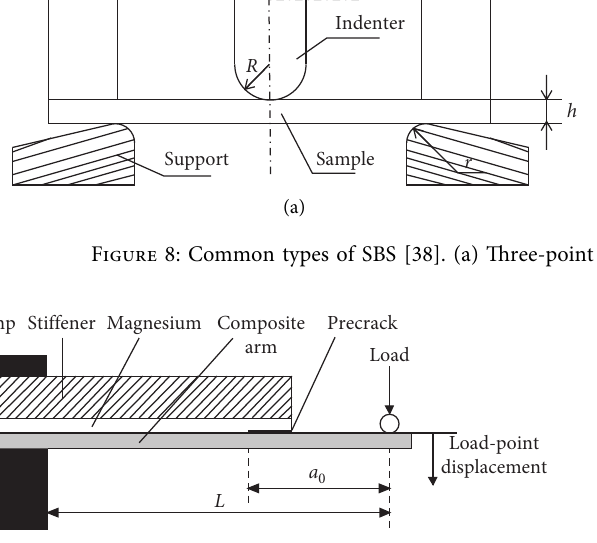
Figure 9: Schematic diagram of SCB test [103].